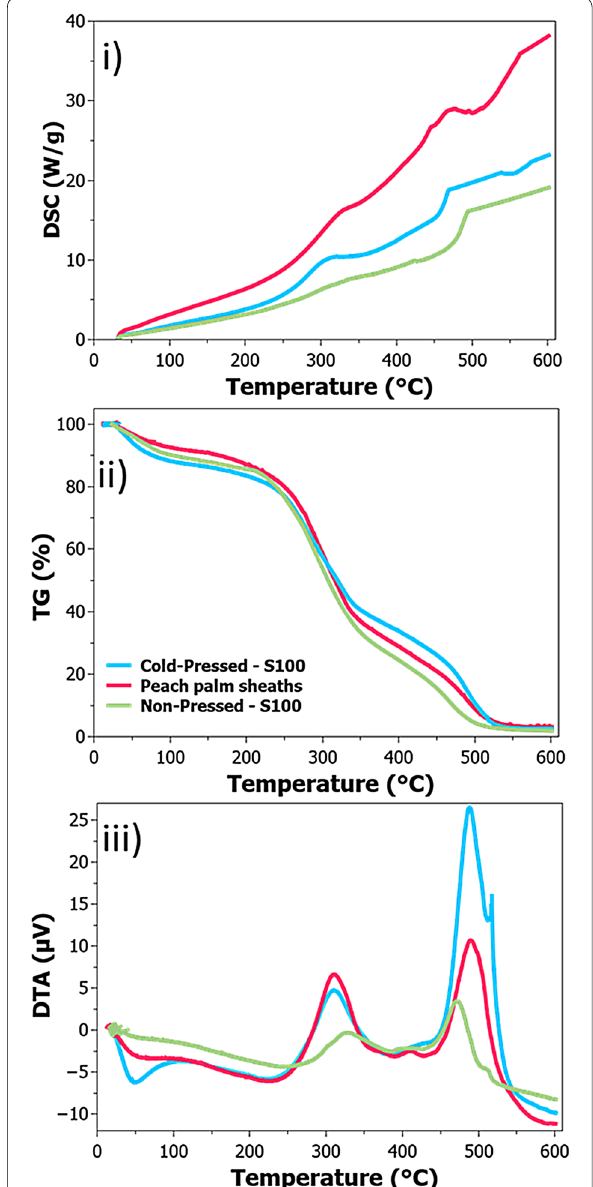
Fig. 7 Thermal analysis of the studied mycelium-based composites (i) DSC, (ii) TG, and (iii) DTA, within the comparisons are the pure raw peach-palm sheaths residue used to grow the